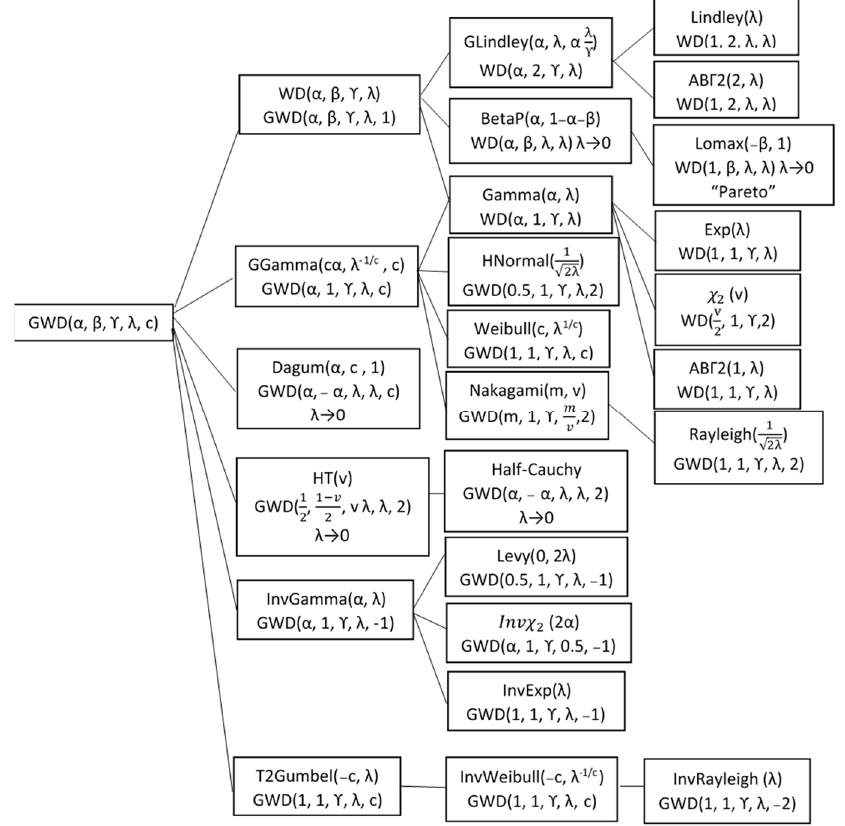
Figure 4. The special cases of 𝐺𝑊𝐷(𝛼, 𝛽, 𝛾, 𝜆, 𝑐) and 𝑊𝐷(𝛼, 𝛽, 𝛾, 𝜆) .